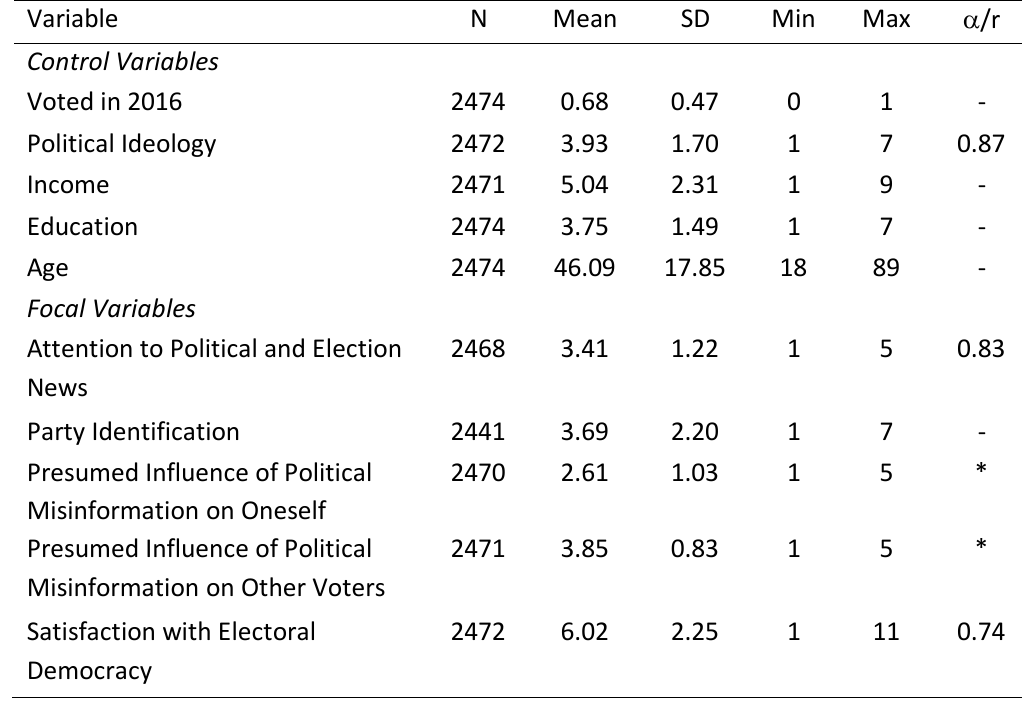
Table A3. Descriptive statistics of variables.